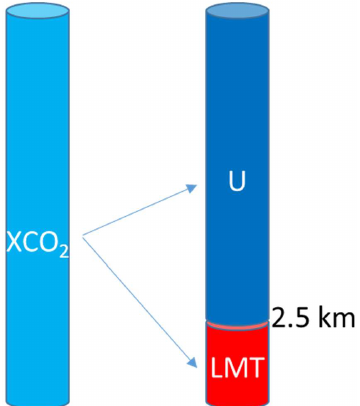
Figure 1. X CO 2 full column measurement (left) and the two par- tial columns that we introduce (right): the lowermost troposphere (LMT), a partial column from the surface to approximately 2.5km, and the partial column above 2.5km ( U